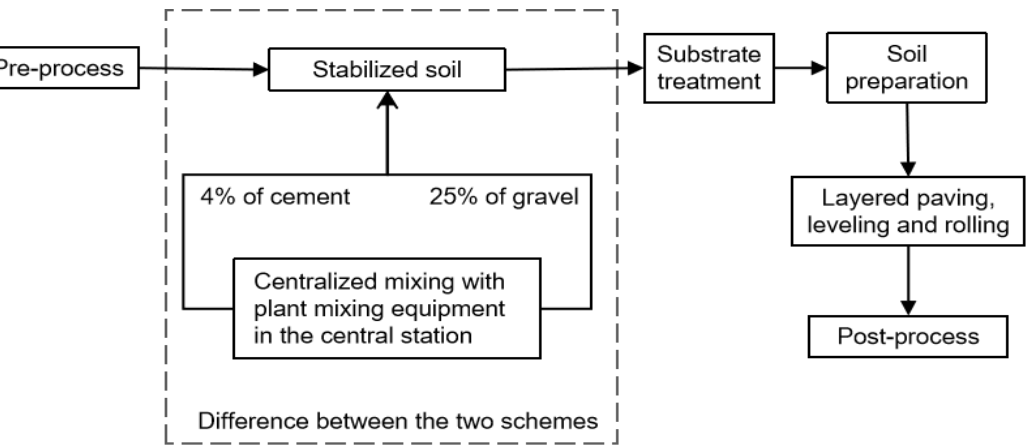
Figure 3. Construction technique of stabilized earth subgrade filling